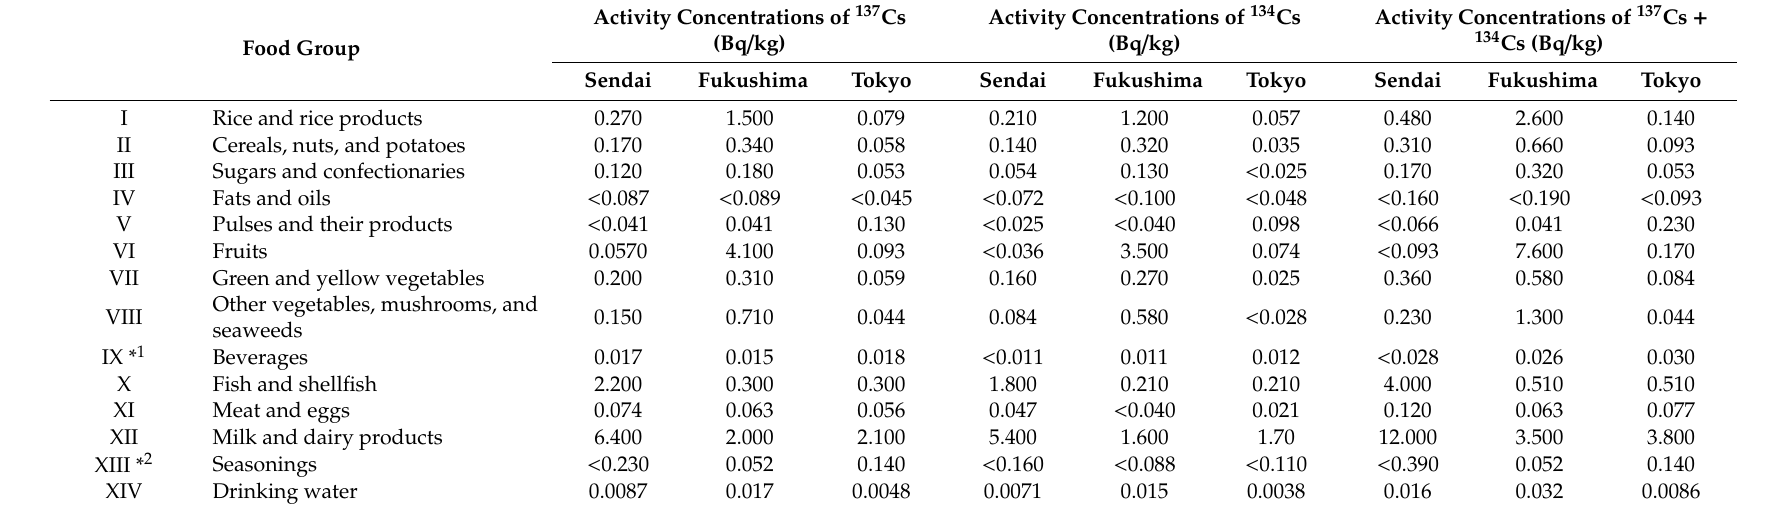
Table 2. Activity concentrations of 137 Cs and 134 Cs in Japanese total diet study samples in